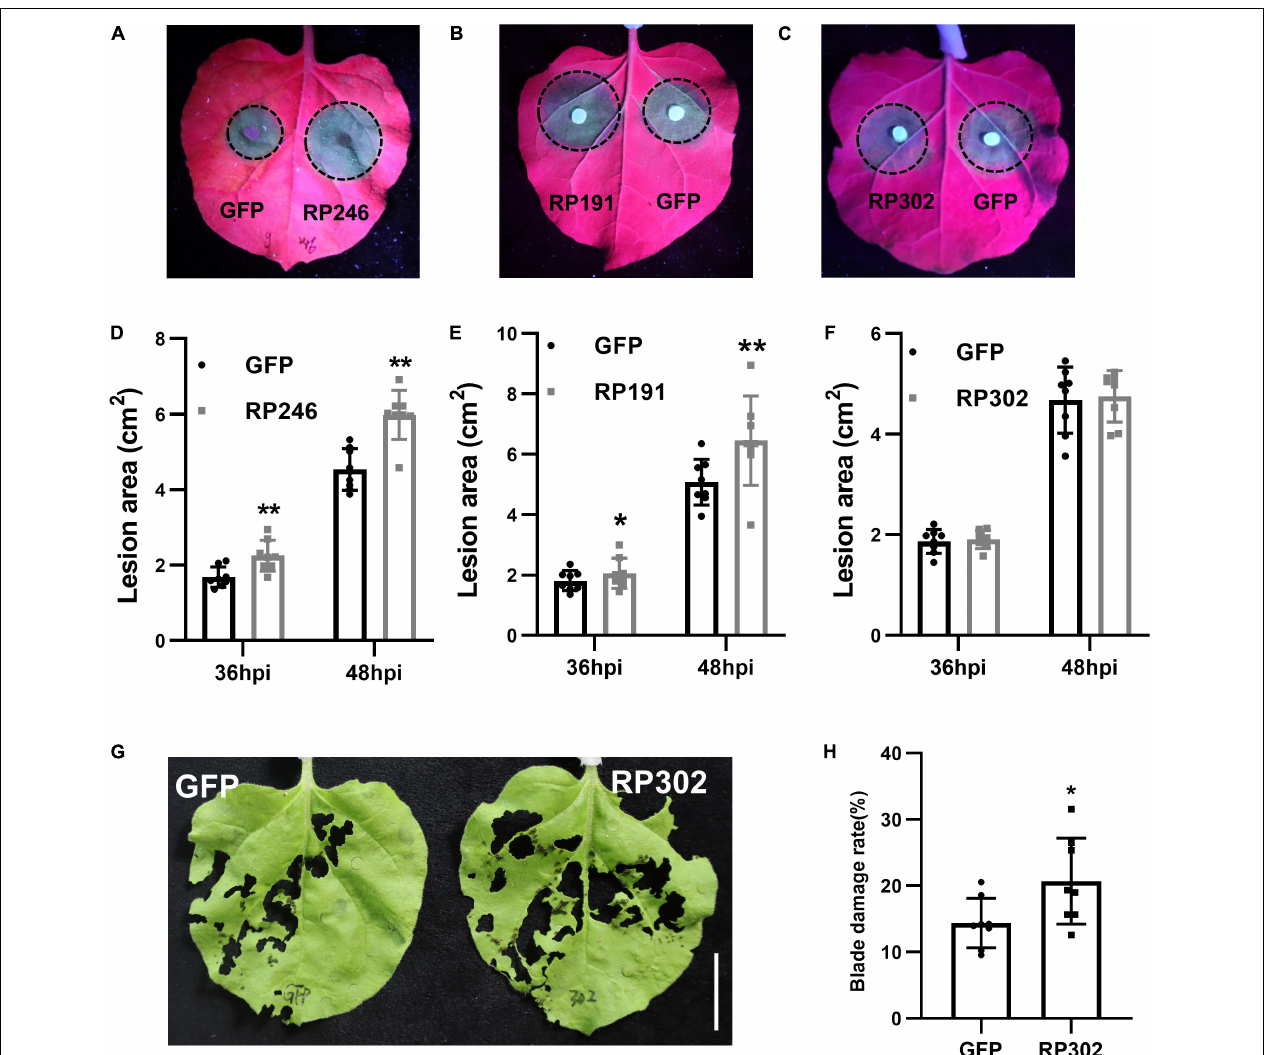
FIGURE 5 | Necrosis-inducing proteins (NIPs) affect plant pathogen infection and insect feeding. (A–C) Phytophthora capsici infection assays with N. benthamiana leaves expressing green fluorescent protein (GFP) or GFP-NIPs. Representative photographs were taken under UV light at 48 hpi and the lesion area was measured at 36 and 48 hpi (D–F) . Average lesion areas were calculated from eight leaves. (G,H) Spodoptera litura feeding on leaves expressing GFP, GFP-RP302. Similar results were obtained in three independent experiments. Asterisks at the top of the bars indicate statistical significance. Error bars represent SD (** P < 0.01, * P < 0.05, Student’s t